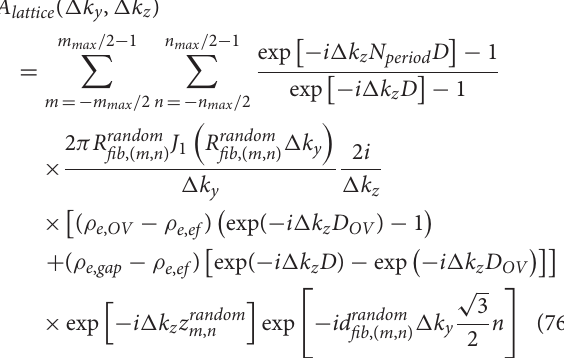
where E characterizes the amount of disorder, and is therefore called disorder parameter. In the same manner, we define a second 1D paracrystalline lattice distorted in two dimensions around an x n axis, which results from the rotation of the x m axis by an angle of γ Figure 5 . This leads to two one-dimensional paracrystals in the transverse plane, one oriented along the x m axis and one around x n axis; the directions of the axes x m and x n are given by the average lattice vectors a and b , see Figure 6A . The components of d a and standard deviations of the paracrystal along the a axis, parallel and normal to this axis, are denoted as d a , d σ a , respectively; their correlation is denoted as ρ a . The same ⊥ parameters along the b axis are denoted as d b , d and their correlation is denoted as ρ b . The position vectors of the lattice points of the two one-dimensional paracrystals are denoted by r m and r n . The position r m , n of the ( m , n )th point of the ideal 2 D paracrystal is given by